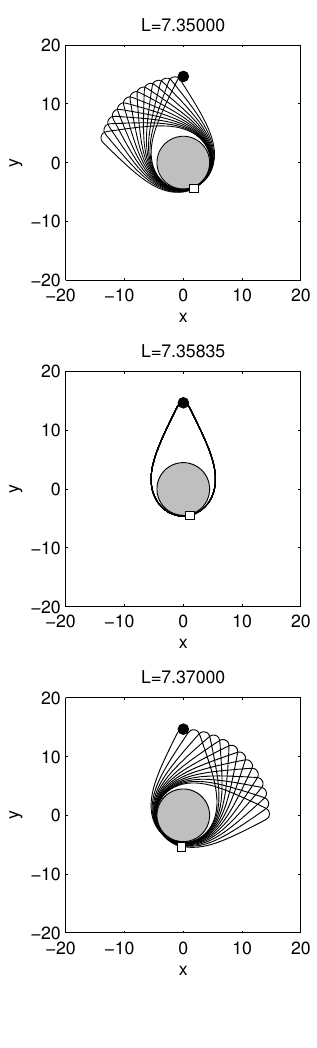
Figure 4. An example of precession as a function of angular momentum for Λ = 1 ( middle panel). For Λ > 1 we find precession in the counter-clockwise direction ( top panel) and for Λ < 1 the orbit precesses in the opposite sense ( bottom panel). Initial positions are plotted as black dots and final positions are